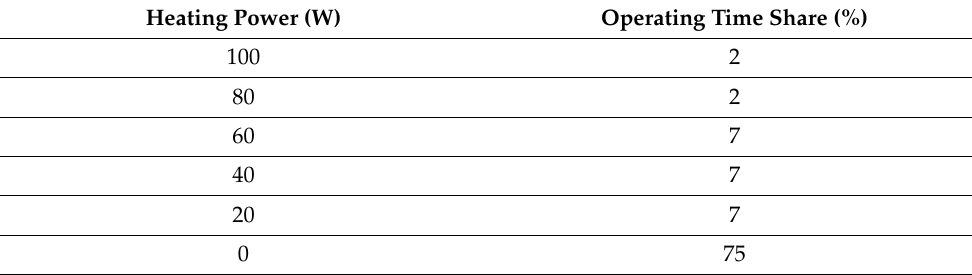
Table 3. Assumed realistic load